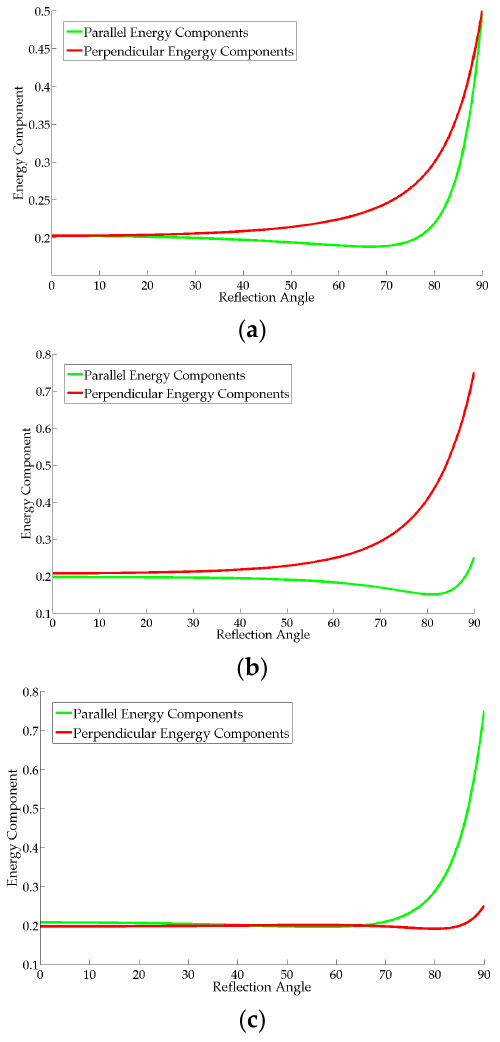
Figure 3. Reflection and refraction energy components from water as function of degree and direction of polarization. ( a ) Unpolarized light; ( b ) Light is three quarters polarized in perpendicular direction with the water plane; ( c ) Light is a quarter polarized in perpendicular direction with the water plane.